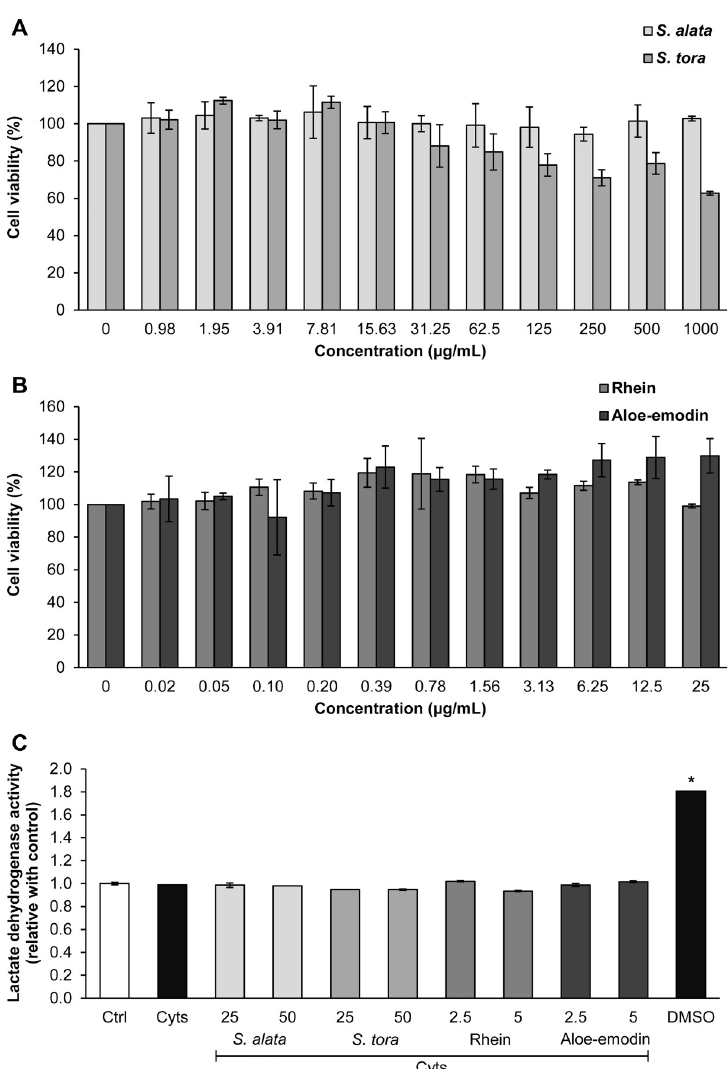
Fig 7. Effect of Senna crude extracts, rhein, and aloe-emodin on cell viability of primary porcine articular chondrocytes and cartilage explants. Senna crude extracts of MTT assays (A), rhein and aloe-emodin (B), in a primary porcine articular chondrocyte culture for 24 h and LDH assay (C) for seven days of the cartilage explant culture. The culture with 10% DMSO was used as the positive control. Results are presented as mean ± SD of the proportion between the treatment group and the untreated control (Ctrl) in triplicate experiments. The difference between the treatments and untreated control was performed by a Student’s t-Test and the asterisk ( � ) indicates a significant difference at p < 0.05. Cyts: the combined cytokines (2ng/mL IL-1 β and 4 ng/mL